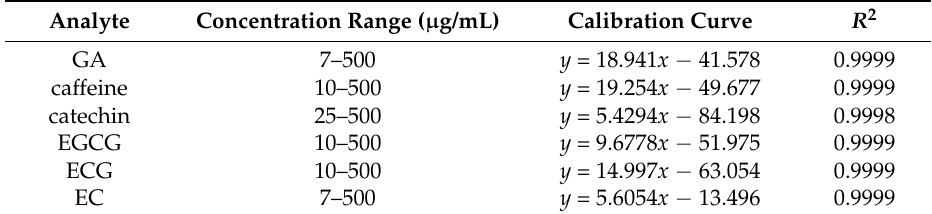
Table 3. Concentration ranges, calibration curves, correlation coefficients of the RP-HPLC-PDA method for gallic acid (GA), caffeine, catechin, epigallocatechin-3-gallate (EGCG), epicatechin-3-gallate (ECG) and epicatechin (EC).